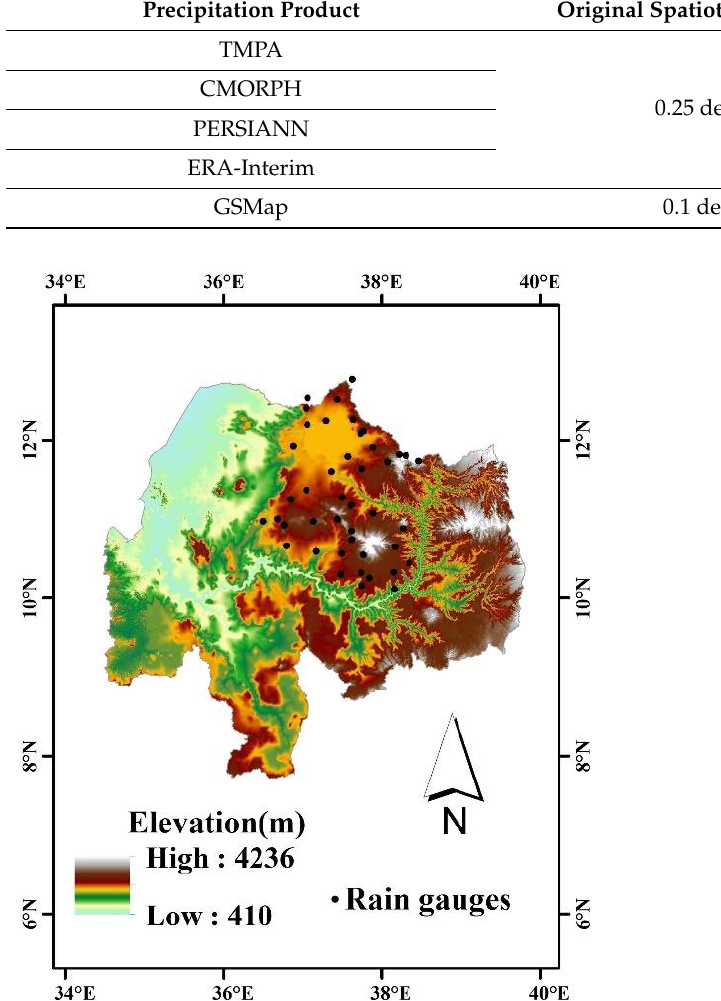
Figure 1. Map of the elevation of the Upper Blue Nile Region (reprinted with permission from [3]). Black dots indicate the locations of rain gauge measurement.